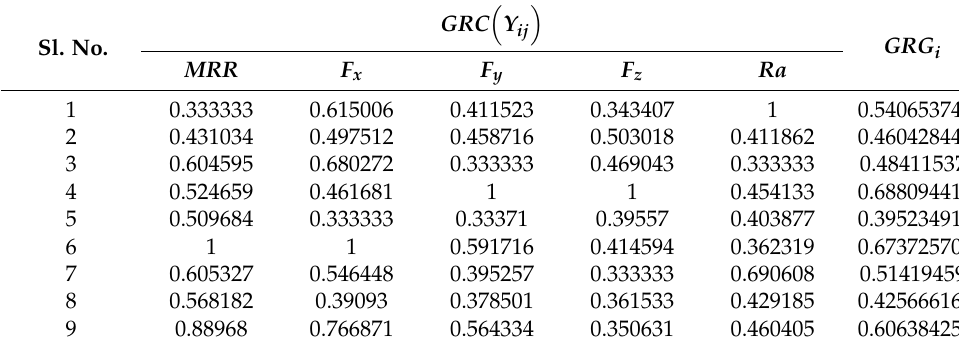
Table 9. Values of GRC and GRG.